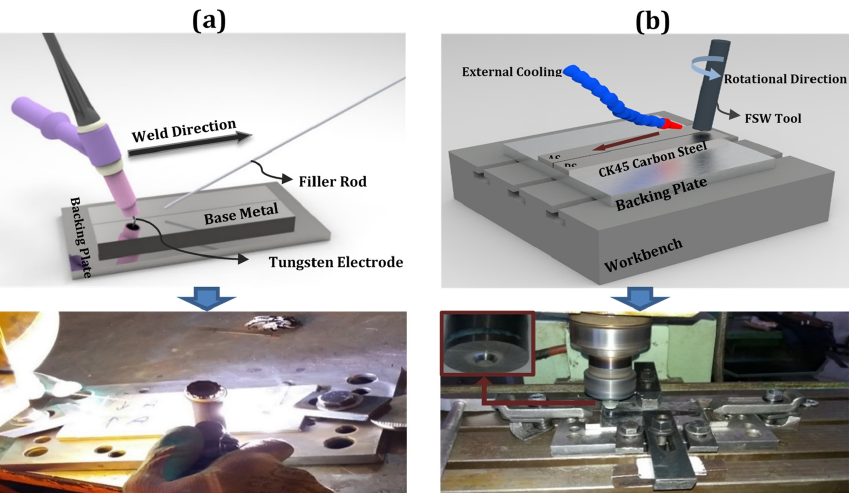
Figure 1. Schematic representation of weld arrangement and actual pictures of ( a ) tungsten inert gas (TIG) and ( b ) friction stir welding (FSW).